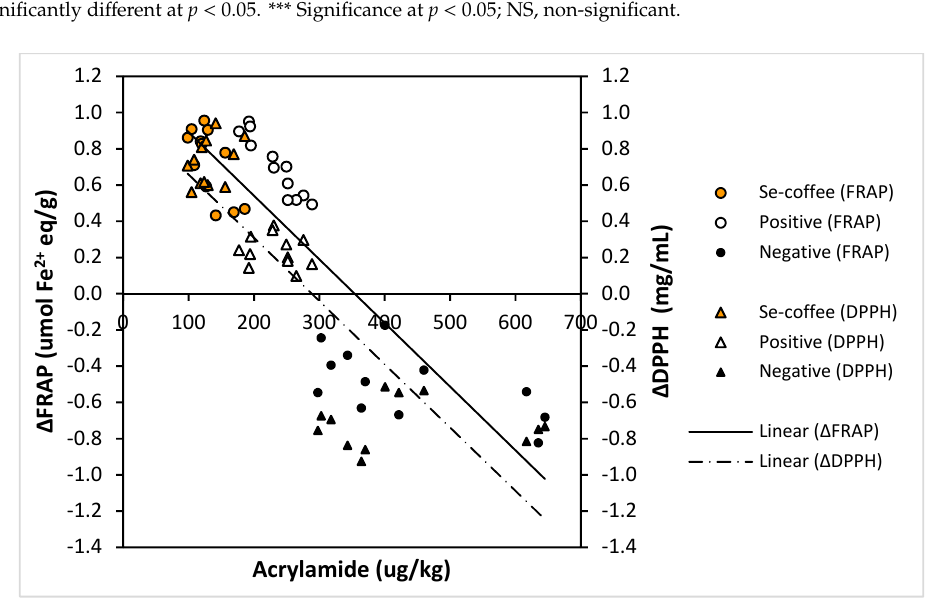
Table 2. FRAP reducing activity and DPPH scavenging activity (expressed as EC 50 ) of Se-coffee, positive control and negative control roasted via conventional (CON) and superheated steam (SHS) roasting.